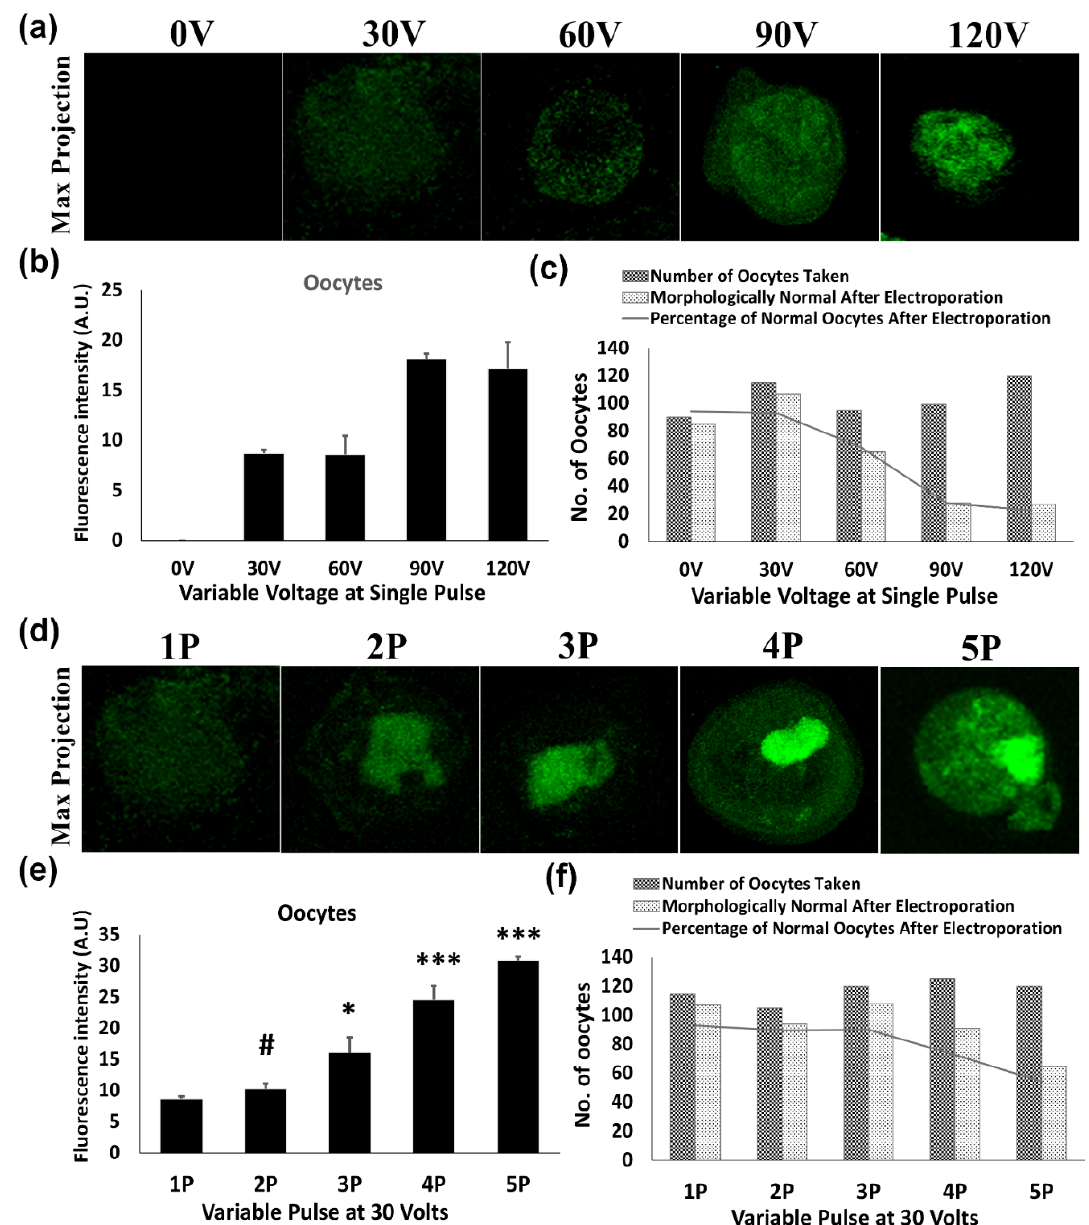
Figure 2. Pictorial representation showing optimization of GFP transfection through electroporation in mouse oocytes. ( a – c ) Increased voltage (60–120 V) at a single pulse reduced the survival rate of mice oocytes, ( d – f ) but lower voltage with multiple pulses showed improvement in the survival along with transfection efficiency up to three pulses (1–3 P of 30 V). After three pulses of 30 V (4–5 P), fluorescence intensity increased but with decreased survival ( χ 2 = 69.22, df = 8, p < 0.0001). The measurement of fluorescent intensity was done by ImageJ software. * p <0.05 and *** p < 0.001 indicate significant differences compared to the single pulse of 30 V. # is non-significant. Original magnification of photomicrographs was ×